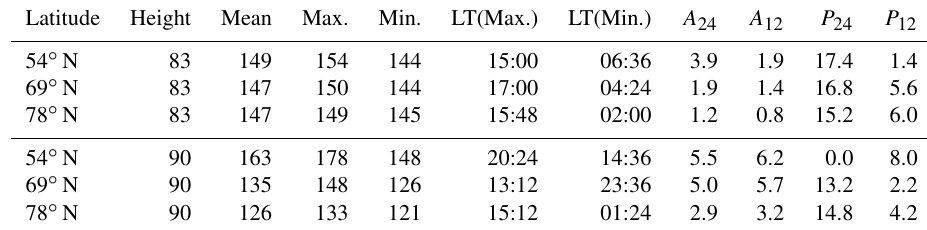
Table 1. Local time variation derived from daily data of temperature (K) for two heights (km) at different latitudes for July 2009; see text for more details. Mean: mean temperature over a daily cycle; Max.: maximum temperature over a daily cycle; Min.: minimum temperature over a daily cycle; LT(Max.): local time (LT) in hours of Max.; LT(Min.): local time (LT) in hours of Min.; A 24 : diurnal amplitude from a harmonic fit including 24 and 12h components; A 12 : same but for the semidiurnal amplitude; P 24 : diurnal phase of A 24 in LT hours of maximum; P 12 : same but for semidiurnal phase. Latitude Height Mean Max. Min.